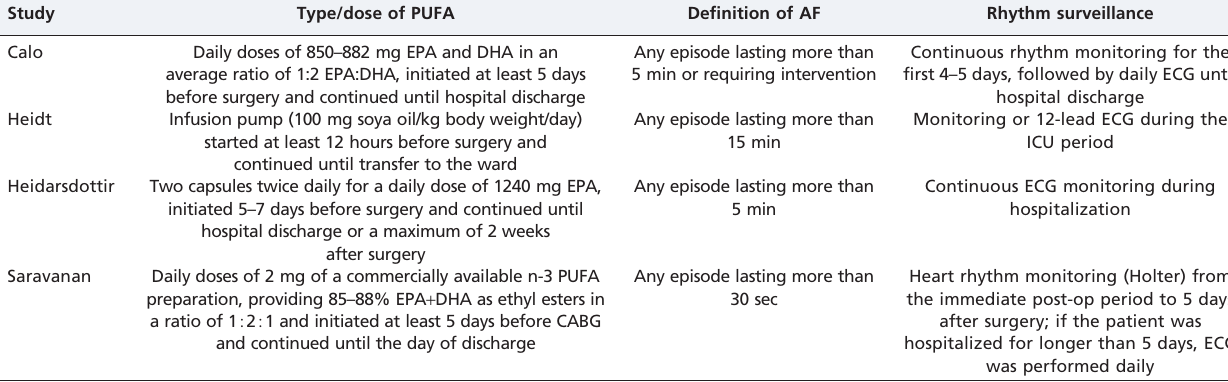
Table 3 - The PUFA type and dose, the definition of AF, and the rhythm surveillance method.